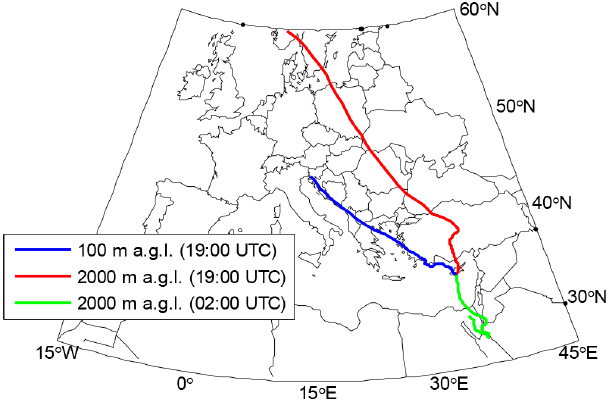
Figure 7. Limassol 27 April 2017 measurements with Halo Doppler lidar. (a) Time series of co-polar SNR at 300s integration time. (b) Time series of cross-polar SNR at 300s integration time. (c) Un- certainty in the depolarization ratio. (d) Particle linear depolariza- tion ratio filtered with σ δ < 0 . 05.